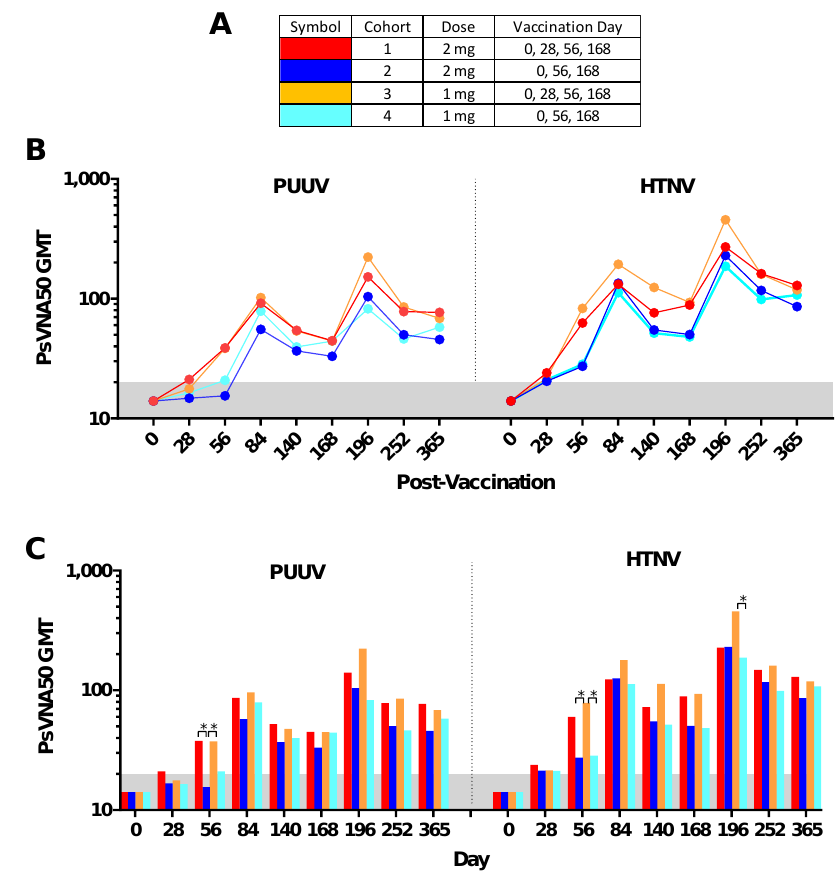
Figure 5. PsVNA geometric mean titers. ( A ) Legend. The PsVNA50 GMT for PUUV and HTNV presented as line graph ( B ) or bar graph ( C ). The limit of quantitation was 20 (grey area). Values <20 were given a value of 14.1. * p -value from post-ANOVA pairwise comparison based on the analysis of log10-transformed titers.